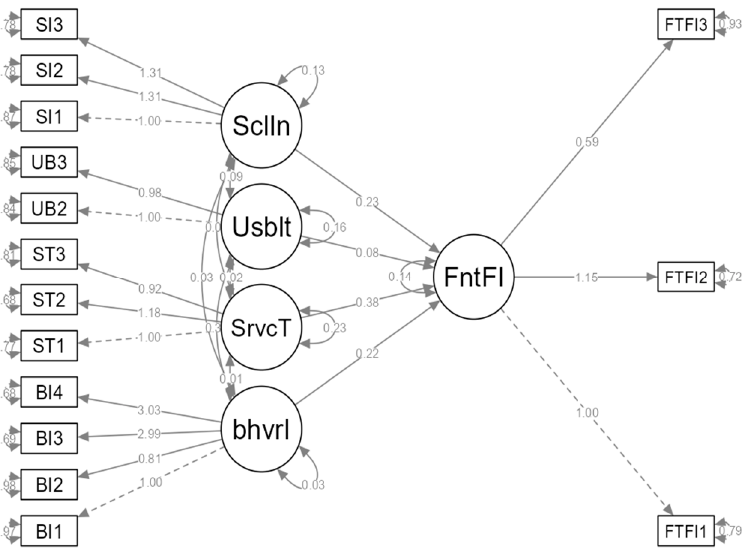
Figure 2. Estimated framework.